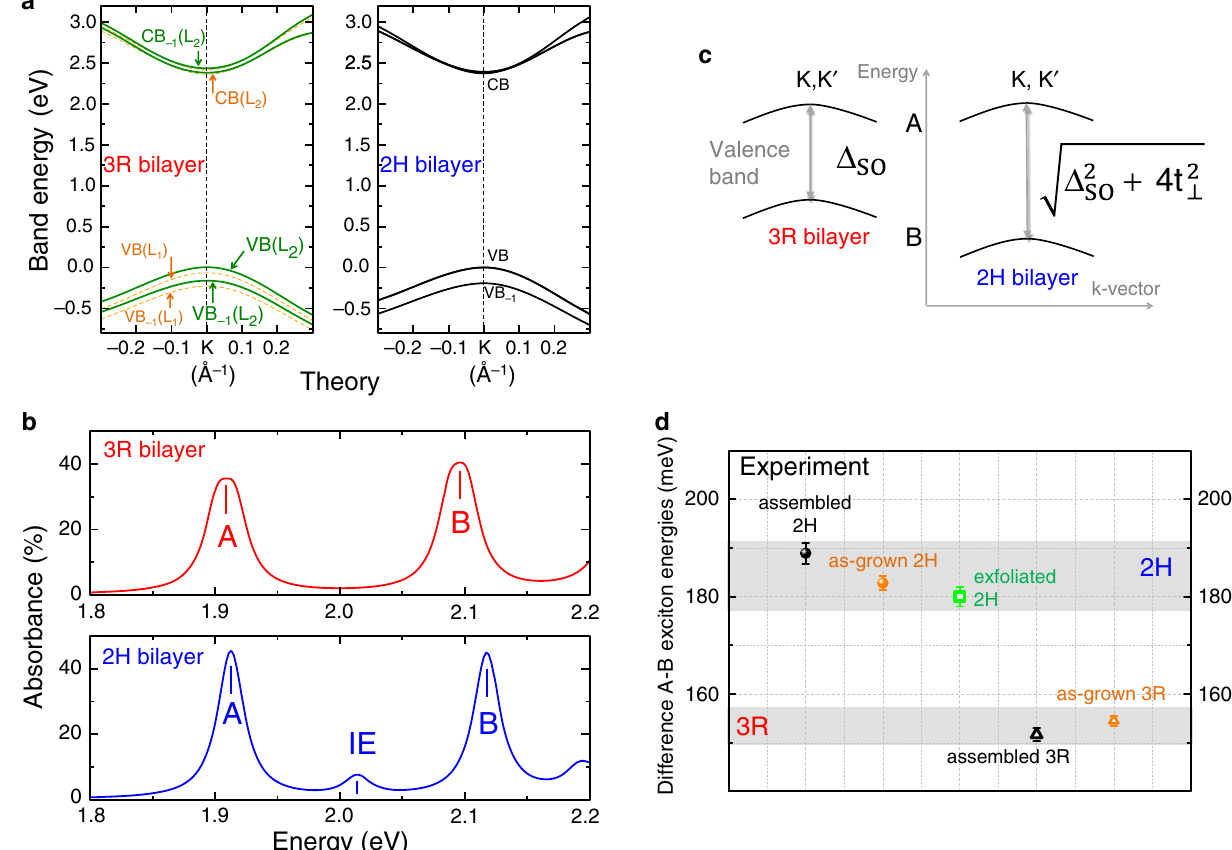
Fig. 3 Interlayer coupling in theory and experiment. a Valence and conduction bands around K-point calculated at the G 0 W 0 level for 2H and 3R stacking, with the energy value of the VB set to 0 in K. b Calculated absorption using G 0 W 0 + BSE approach for both stackings, see “ Methods ” for the computational details. Complete band structures are given in Supplementary Fig. 4. c Schematic of the A- and B-valence bands for 3R bilayers (left) and 2H bilayers (right) as a function of the spin – orbit splitting Δ SO and the interlayer coupling parameter t ⊥ . d Energy difference between B- and A-exciton for the as-grown (orange), as well as arti fi cially-assembled (black) 2H and 3R MoS 2 homobilayers. The error bars represent the standard deviation extracted over 10 different spectra in each case. Gray shaded area is a guide to the eye to underline clear differences between 3R and 2H bilayers.